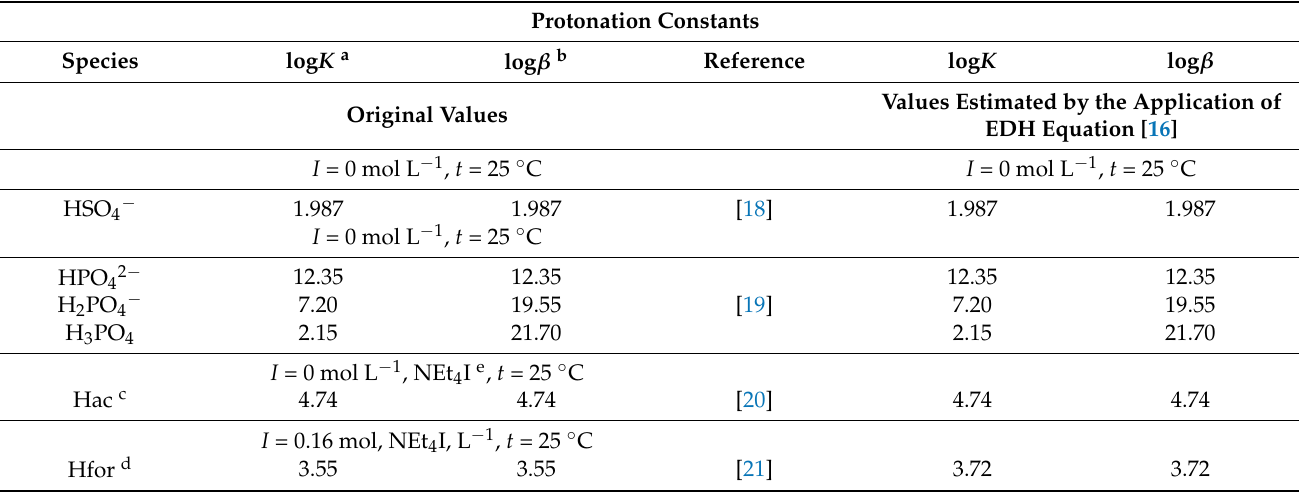
Table 2. Overall (log β ) and partial (log K ) protonation constants of the species considered in the model. Protonation